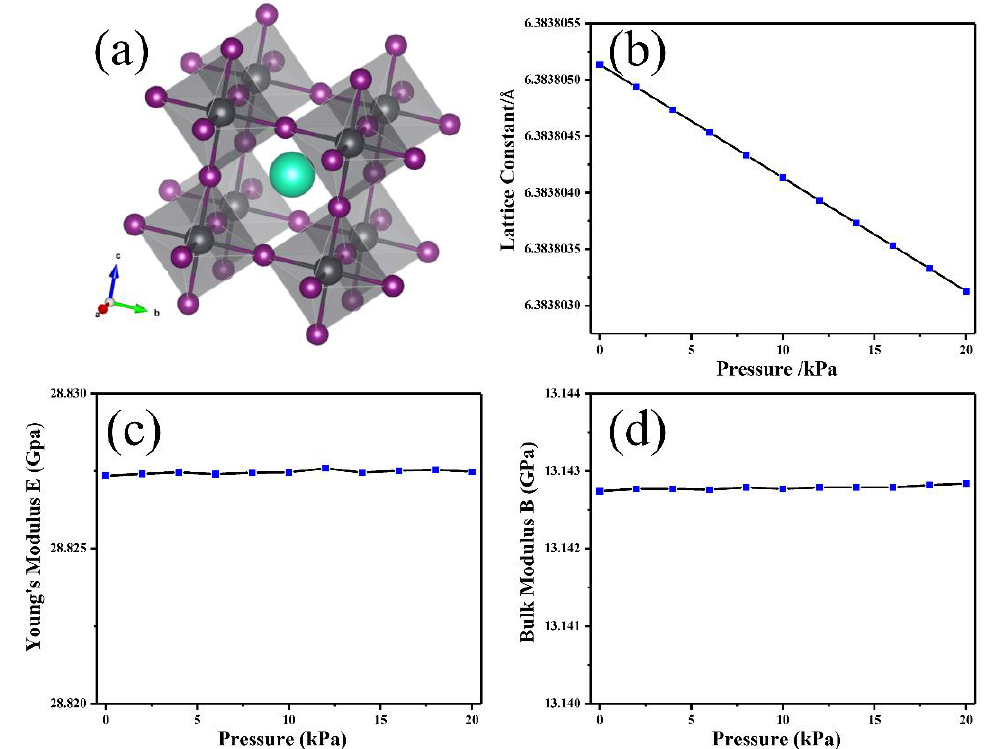
Figure 1. The crystal structure and mechanical properties of perovskite CsPbI 3 . ( a ) The crystalline structure of cubic CsPbI 3 . ( b ) Lattice constants, ( c ) Young’s modulus E and ( d ) Bulk modulus B under different pressure.